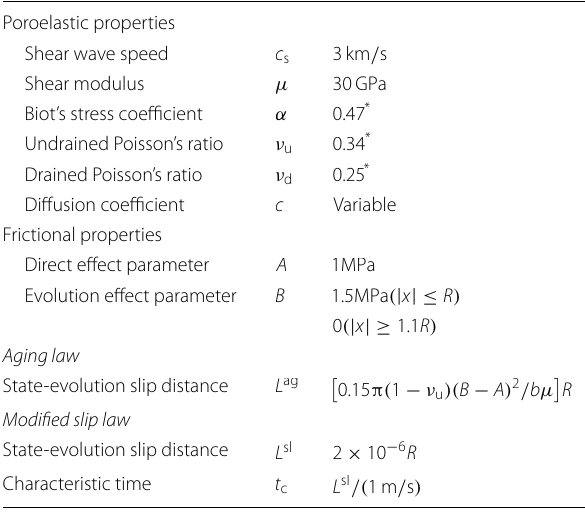
* Properties for granite in Wang (2001) The other poroelastic properties appearing in the main text ( M and κ ) can be expressed in terms of the properties listed here. Parameter studies in terms of c were